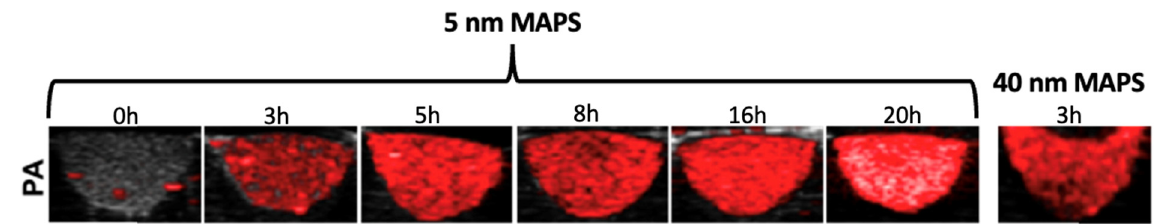
Figure 10 . PA images of EGFR+ A431 cells labeled with 5 nm MAPS for different periods of time. PA images of 40 nm MAPS for comparison [144].